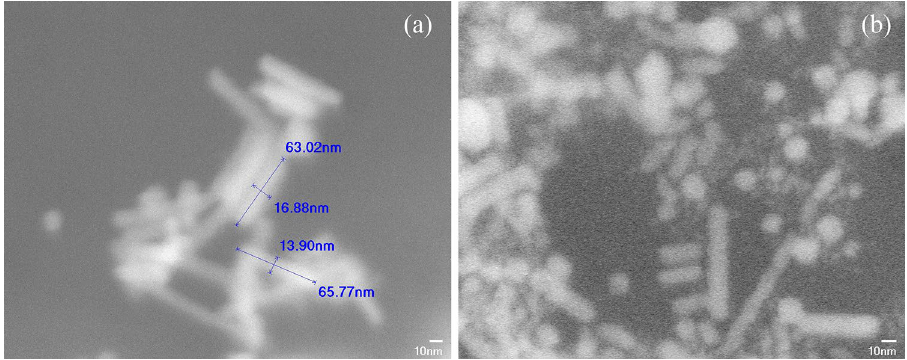
Figure 3. SEM image of an assembly of nanorods. ( a ) before irradiation, nanorods with different sizes and aspect ratio can be seen with length from 30 to 70 nm and width ranging from 10 to 18 nm. ( b ) Nanorods after being irradiated at 10 6 J/m 2